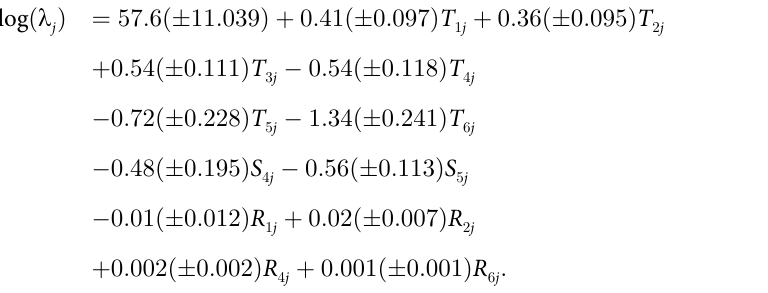
Mean squared errors for the validation data set ( MSE were used to select the best prediction model. These measures were calculated while performing LOOCV as given in S8 and S9